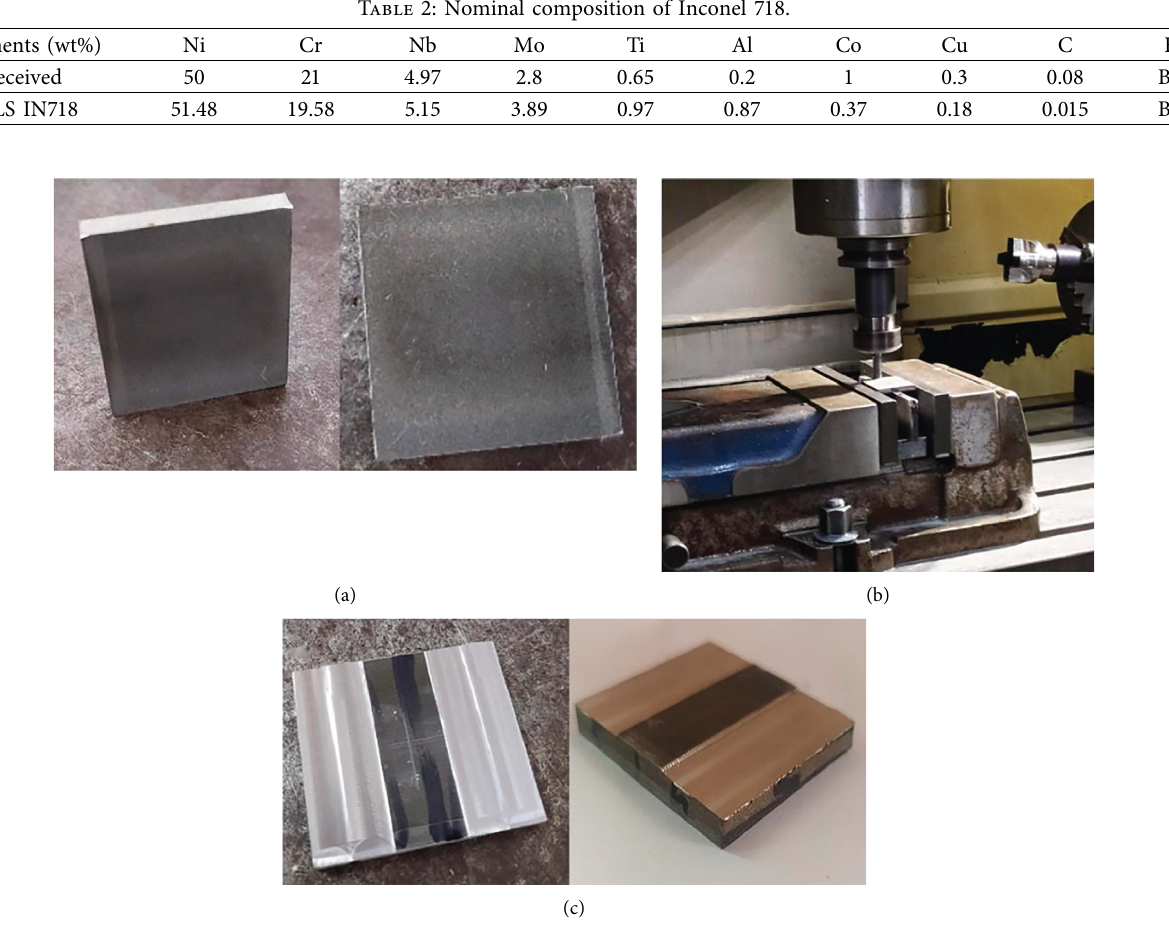
Figure 2: (a) DMLS Inconel 718 sample, (b) milling process, and (c) machined sample.